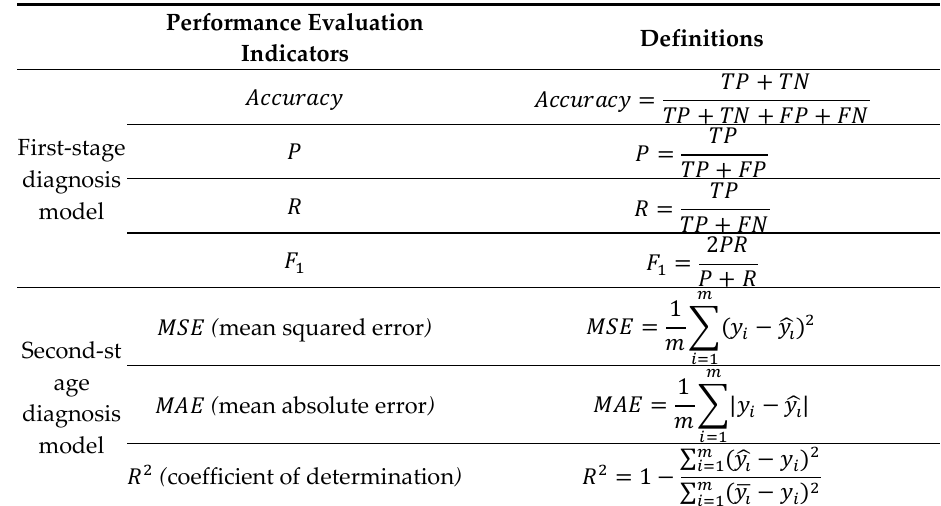
Table 1. Model performance evaluation